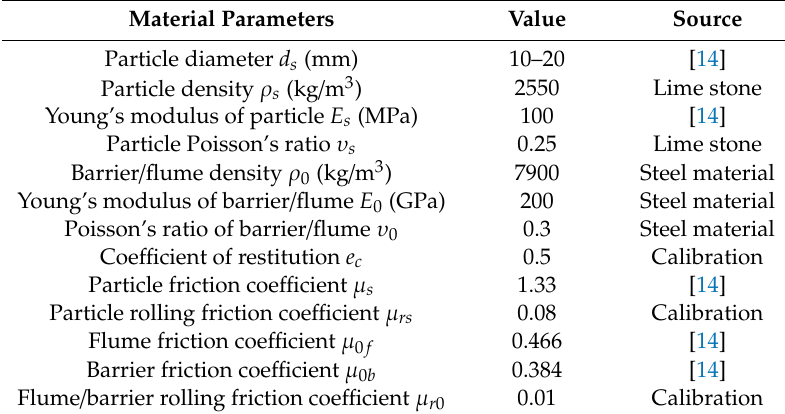
Table 1. DEM input parameters.